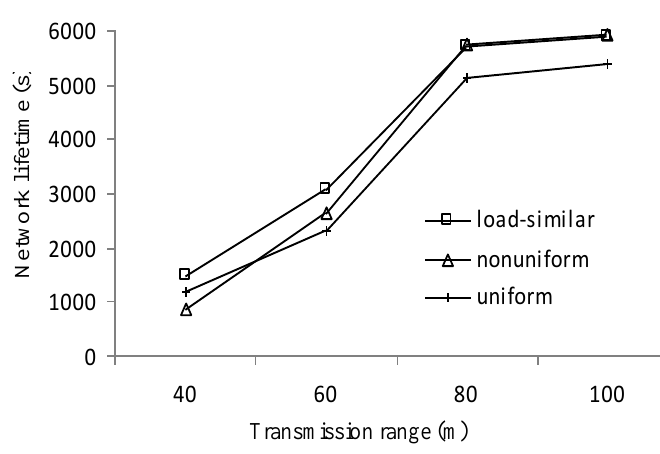
Figure 9. Network lifetime vs. r